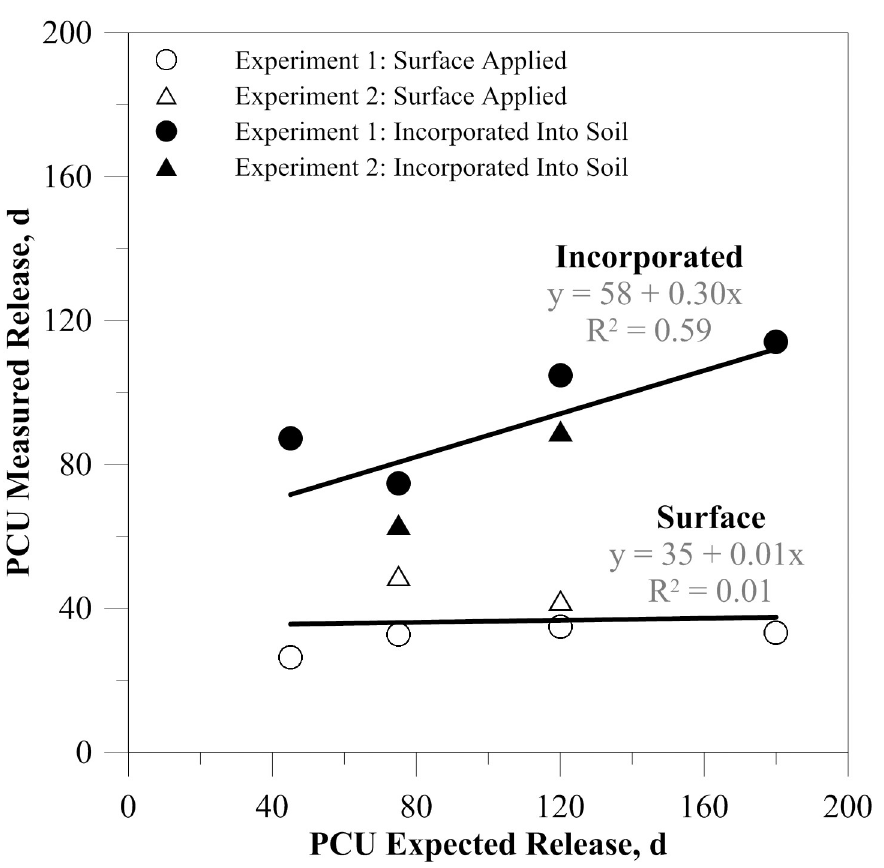
Fig 6. Measured vs. expected N release from (PCU) polymer-coated urea products with varying release timings. Fertilizers were applied to the soil surface or incorporated into the soil under fluctuating daily temperatures. The expected values were those listed by the manufacturer as the number of days to release 80% N at 20˚C (e.g., PCU 45 = 45 d). The measured values were the estimated number of days it took to reach 80% N release based on the intercept and slope coefficients of each PCU source and treatment scenario from experiments 1 and 2 (Tables 1 and 2).